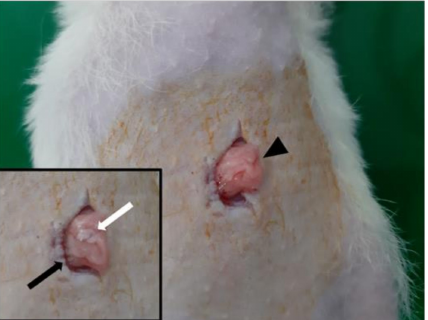
Figure 1. The extracted pituitary gland (white arrow) was placed on the omentum (black arrow). Thereafter, the gland was packed within the omental pouch (black arrowhead).